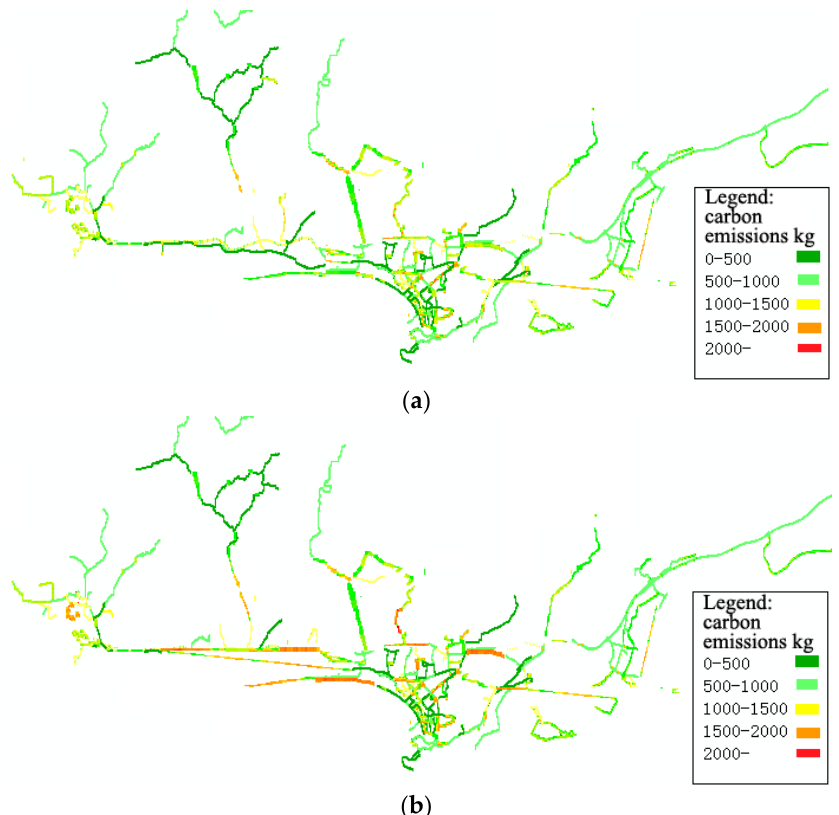
Figure 8. Spatial distribution of buses’ carbon emissions in Sanya on weekdays. ( a ) Spatial distribution of carbon emissions in the morning. ( b ) Spatial distribution of carbon emissions in the evening peak.